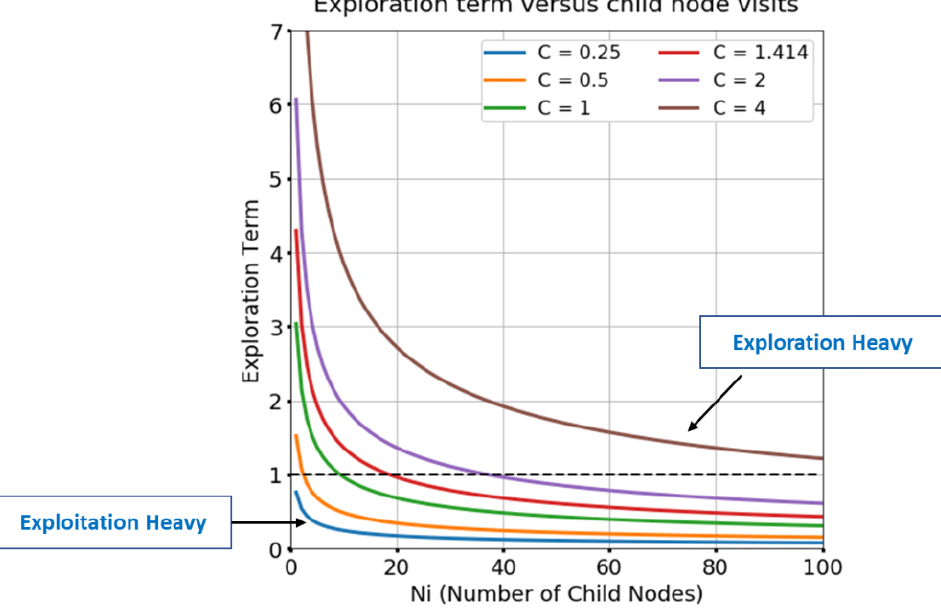
Figure 13. Calculation of exploration terms for different C exp values as a function of the number of child node visits, given a total of 100 visits to the parent node.